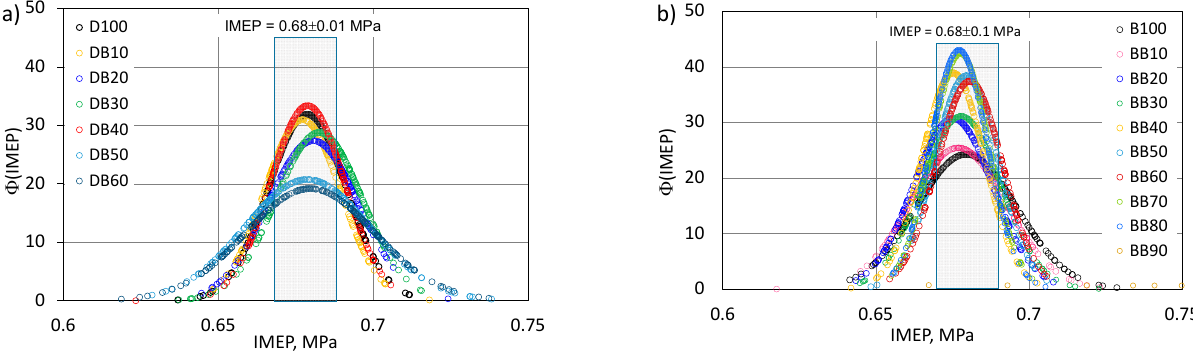
Figure 16. Probability density function of IMEP for DB ( a ) and BB ( b ).